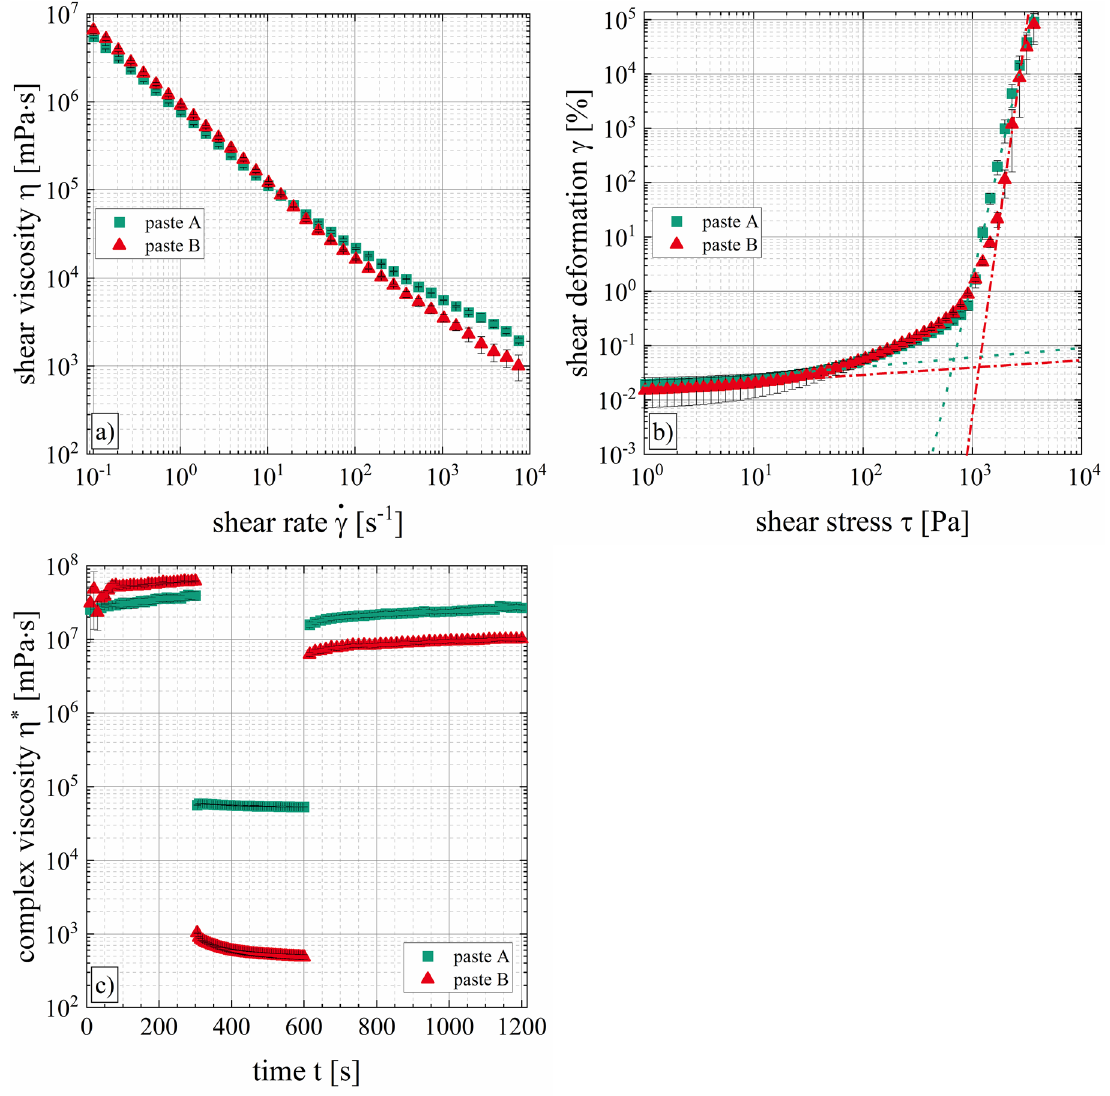
Figure 3. Shear rheological characterization of low-temperature curing Ag pastes A and B determined by TwinDrive rotational rheometer from Anton Paar GmbH, Germany, at T = 25 °C. ( a ) The shear viscosity η is plotted as a function of the shear rate ˙ γ , showing shear-thinning behavior of both pastes. ( b ) The shear deformation γ over the shear stress τ is measured to determine the static yield stress τ f using the tangent intersection method. ( c ) In addition, the result of the three interval thixotropy test is